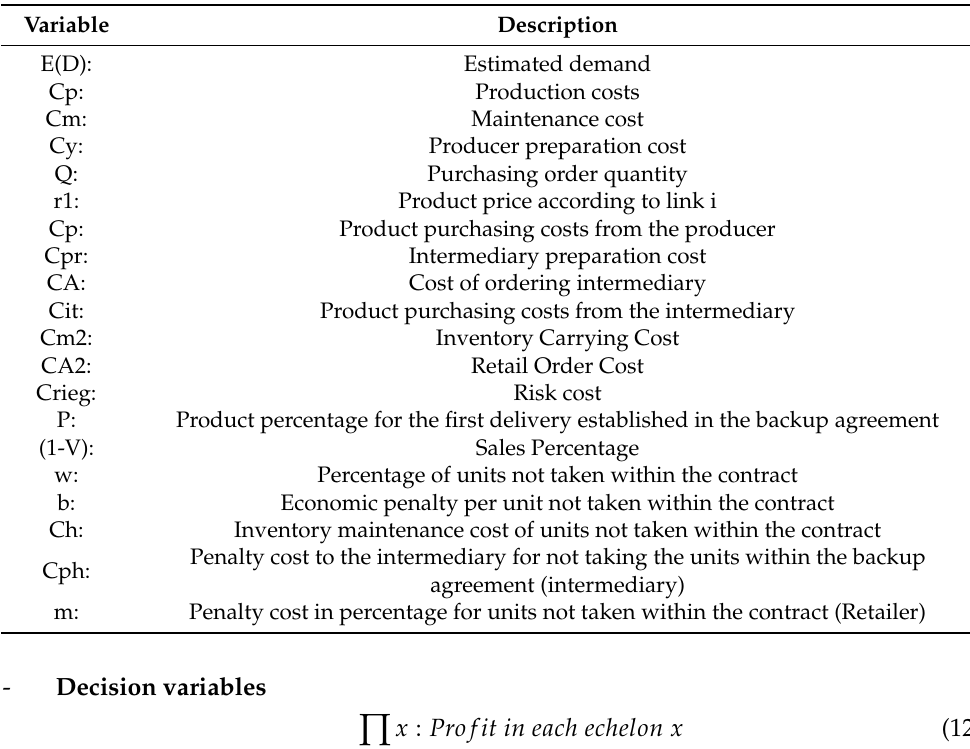
Table 4. Parameters Contract model application.